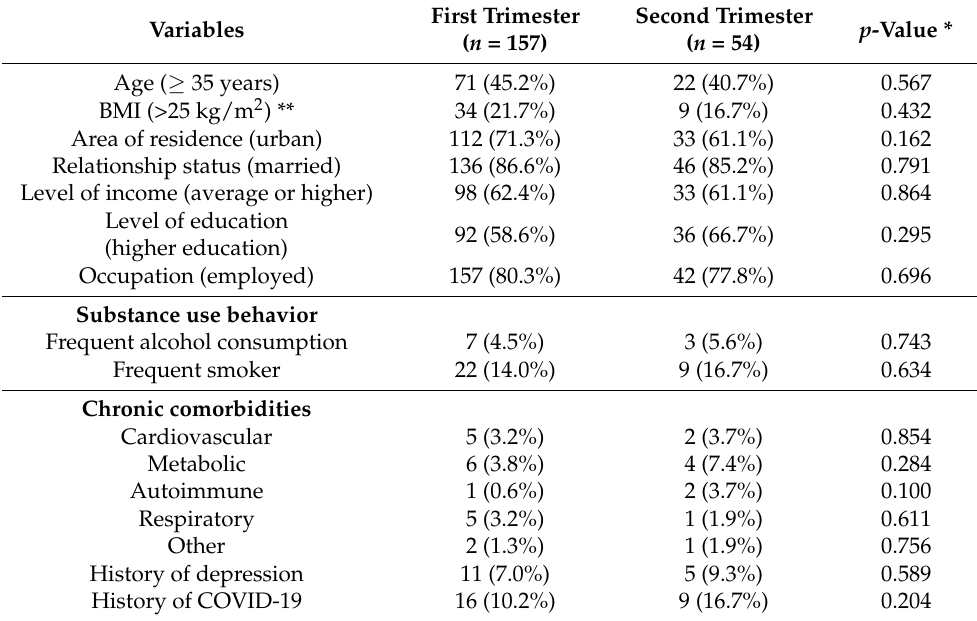
Table 1. Comparison of patients’ socio-demographic and clinical